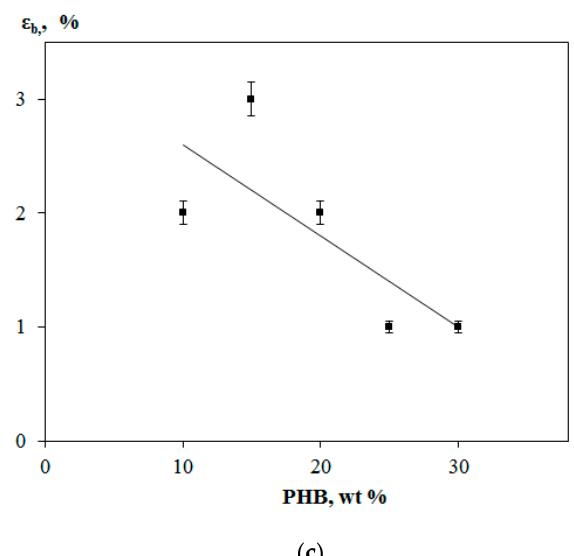
Figure 3. Elastic modulus E ( a ), tensile strength σ b ( b ), and elongation at break ε b ( c ) of PLA − PHB − PEG 1000 compositions vs. PHB content.